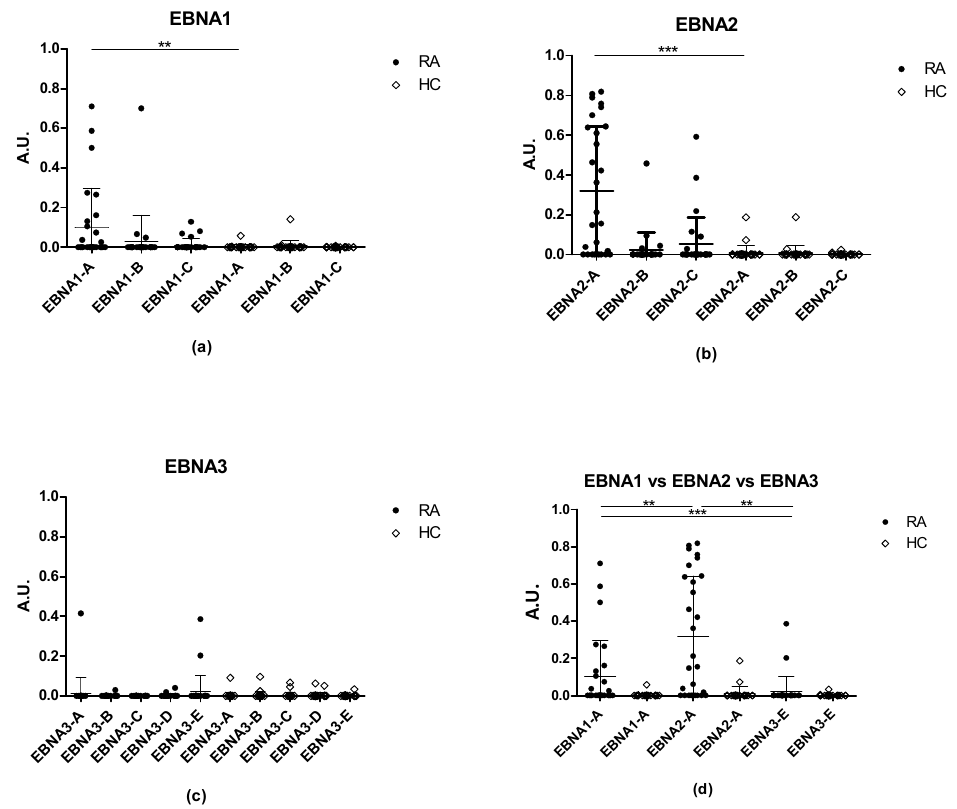
Figure 1. Reactivity of rheumatoid arthritis (RA) samples ( n = 28) and healthy (HC) samples ( n = 28) to biotinylated citrullinated EBNA1, EBNA2, and EBNA3 peptides: ( a ) Reactivity of RA and HC samples to EBNA1 peptides; ( b ) Reactivity of RA and HC samples to EBNA2 peptides; ( c ) Reactivity of RA and HC samples to EBNA3 peptides; ( d ) Reactivity of RA and HC samples to the most reactive EBNA peptides. ** = p < 0.05, *** = p < 0.001.